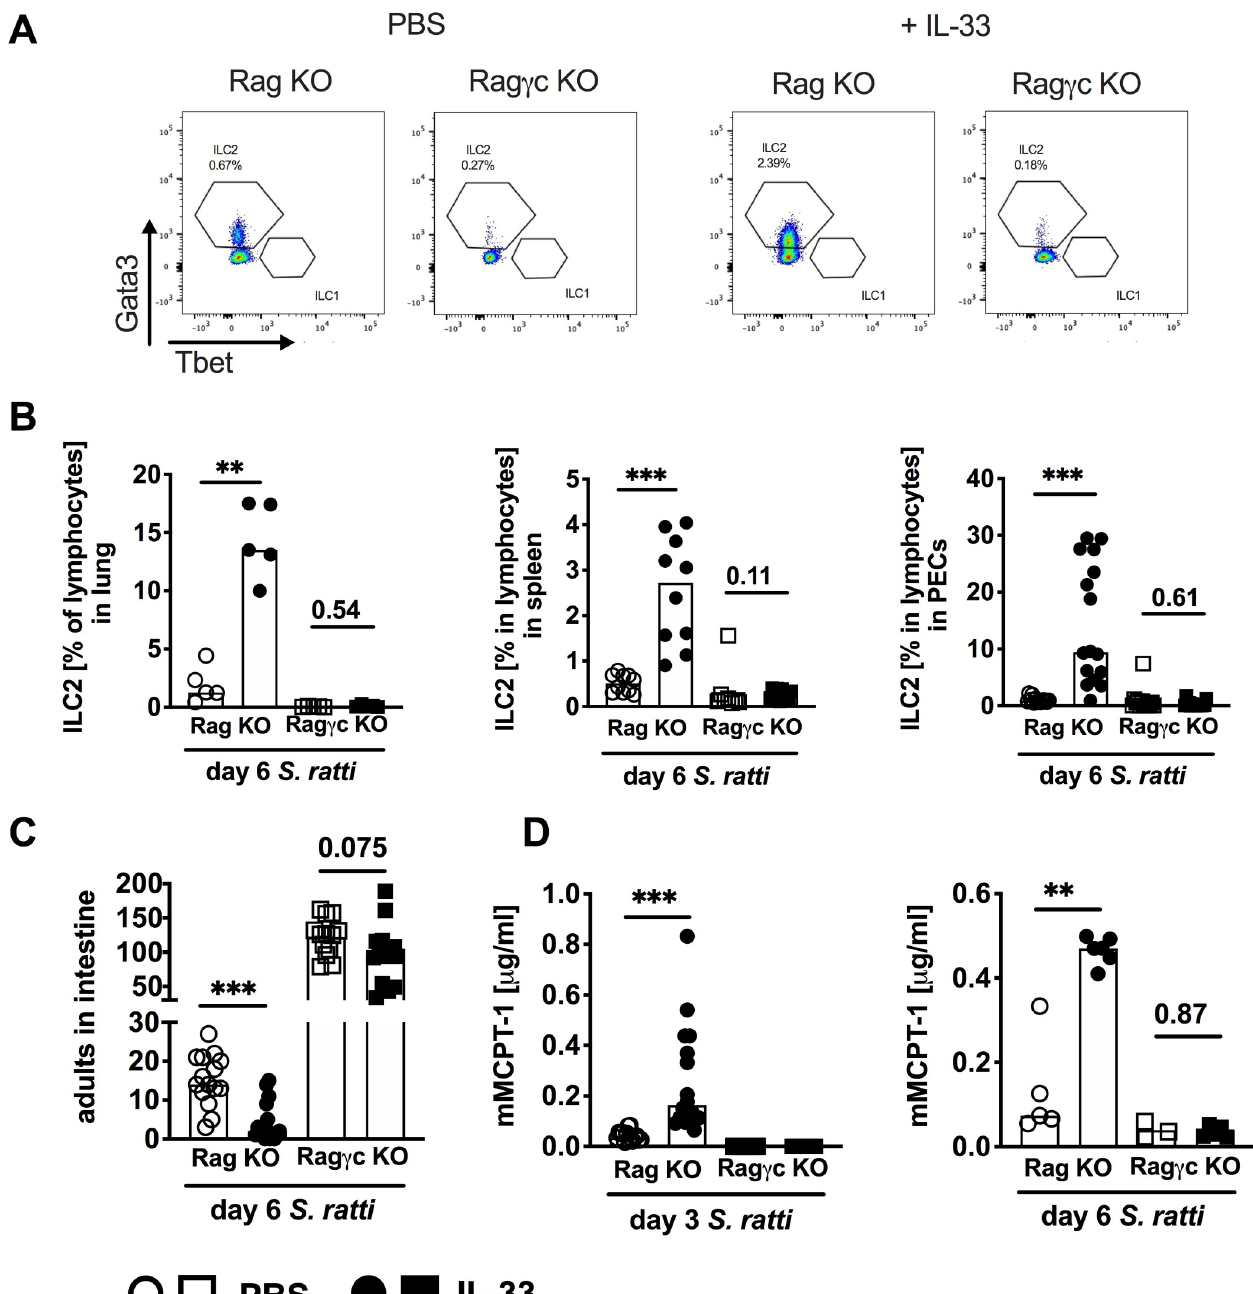
Fig 5. ILC promote IL-33-mediated S . ratti expulsion from the intestine. (A-D) BALB/c RAG -/- mice (circles) and BALB/c RAG -/- γ c -/- mice (squares) were treated i.p. with 1 μ g of IL-33 (closed symbols) or with PBS (open symbols) 3 h before and 24 h post S . ratti infection. (A) Representative dot blots showing frequency of ILC2 in spleens of BALB/c RAG -/- mice or BALB/c RAG -/- γ c -/- mice with or without IL-33 treatment. Cells were measured using an LSRII Cytometer (BD, Germany) and analyzed by FlowJo software. (B) Frequencies of lung, spleen and PEC cells day 6 p.i. Graphs show combined results from 1 (lung), 2 (spleen) or 3 (PEC) independent experiments. (C) Parasitic adults in the intestine were counted 6 days p.i. and (D) mMCPT-1 concentration in the sera was quantified at indicated time points p.i. Graphs show combined results from 3 independent experiments (n = 4 per experiment and group) or 1 experiment (day 6 mMCPT-1). Each symbol represents an individual mouse, bars show the mean, asterisks indicate statistically significant differences of the mean, numbers indicate p value (Mann-Whitney test ( B and D ) and students t-test ( C ).